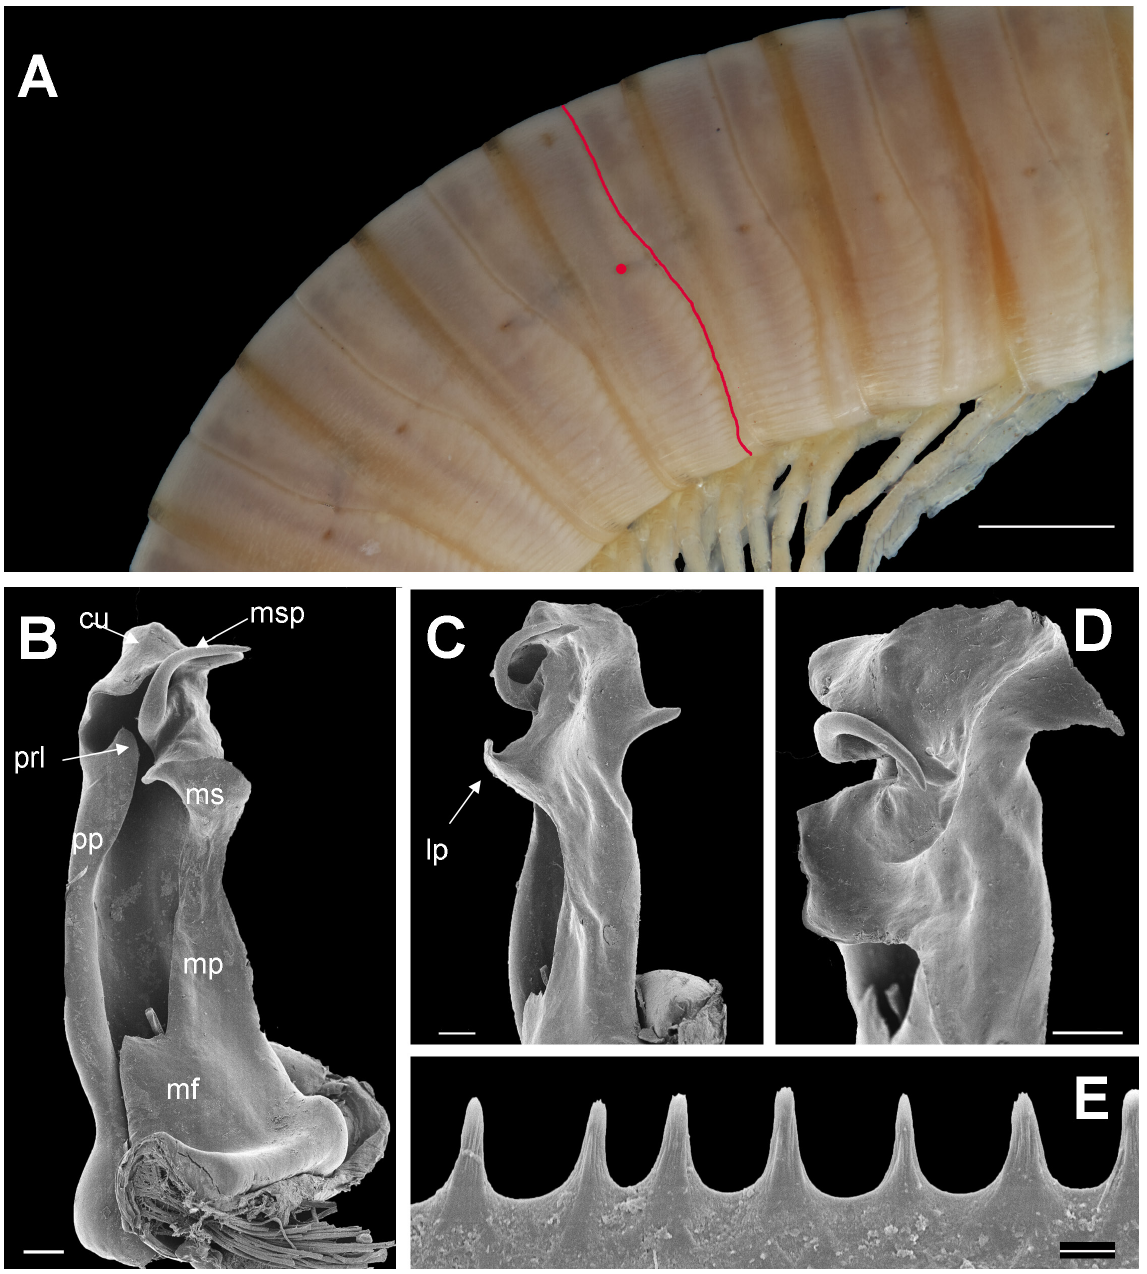
Fig. 5. Yia geminispina gen. et sp. nov., holotype. A . Part of midbody showing the characteristic course of the suture and the position of the ozopore (highlighted in red on one body ring). B–D . Left gonopod coxa. B. Anterior-mesal view. C. Posterior view. D. Mesal view, close-up. E . Limbus. Abbreviations: cu = cucullus, lp = lateral coxal process, mf = metaplical flange, mp = metaplica, ms = metaplical shelf, msp =metaplical spine, pp = proplica, prl = proplical lobe. Scales: A = 1 mm; B–D = 0.1 mm; E = 0.005